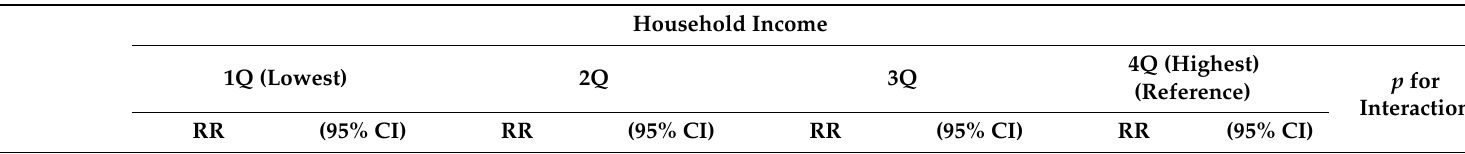
Table 3. The associations between maternal mortality and income levels, stratified by maternal age, residential areas, mode of delivery, and maternal comorbidities after adjusting for all